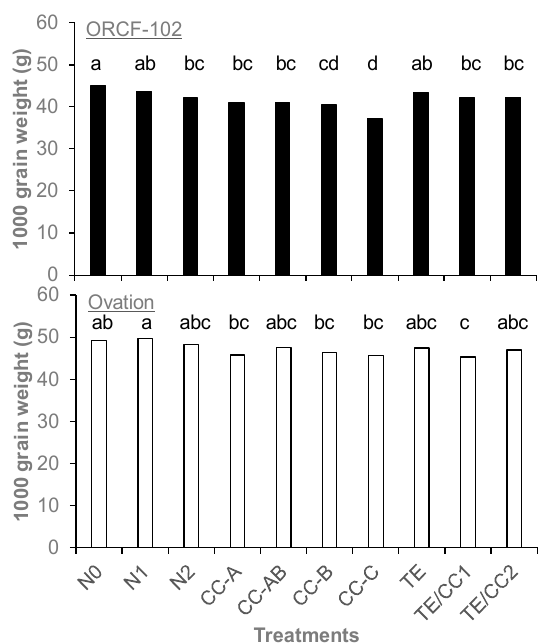
Figure 5. 1000-grain weight (g) of two SWWW varieties among the treatments across the data of two years in Adkins fine sandy loam soil. N0 = no fertilization; N1 = normal N rate; N2 = high-N rate without PGR application; CC-A = applying CC at GS30-32; CC-AB = applying CC at GS30-32 and GS37-39; CC-B = applying CC at GS37-39; CC-C = applying CC at GS21-26; TE = applying TE at GS30-32; TE/CC1 = applying TE at GS30-32 and applying CC (0.442 L ha − 1 a.i.) at GS37-39; TE/CC2 = applying TE at GS30-32 and applying CC (1.004 L ha − 1 a.i.) at GS37-39. Different letters on the top of each column indicate significant differences among treatments at 5% level according to LSD test.